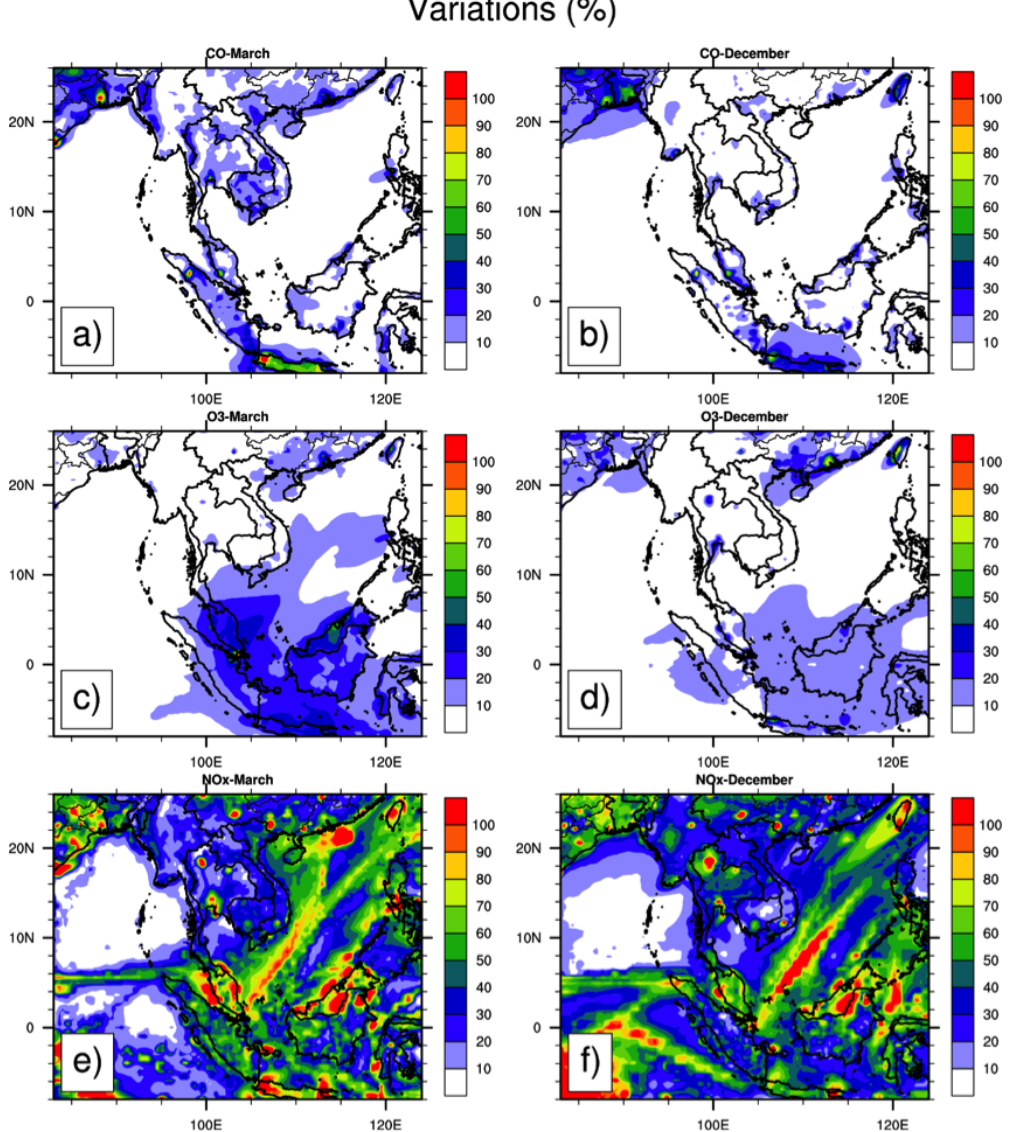
Figure 8. Variations of surface mixing ratios for (a) and (b) CO, (c) and (d) O 3 (e) and (f) NO x predicted by WRF-Chem using the averaged from five emission inventories for March (left) and December (right panels) 2008.